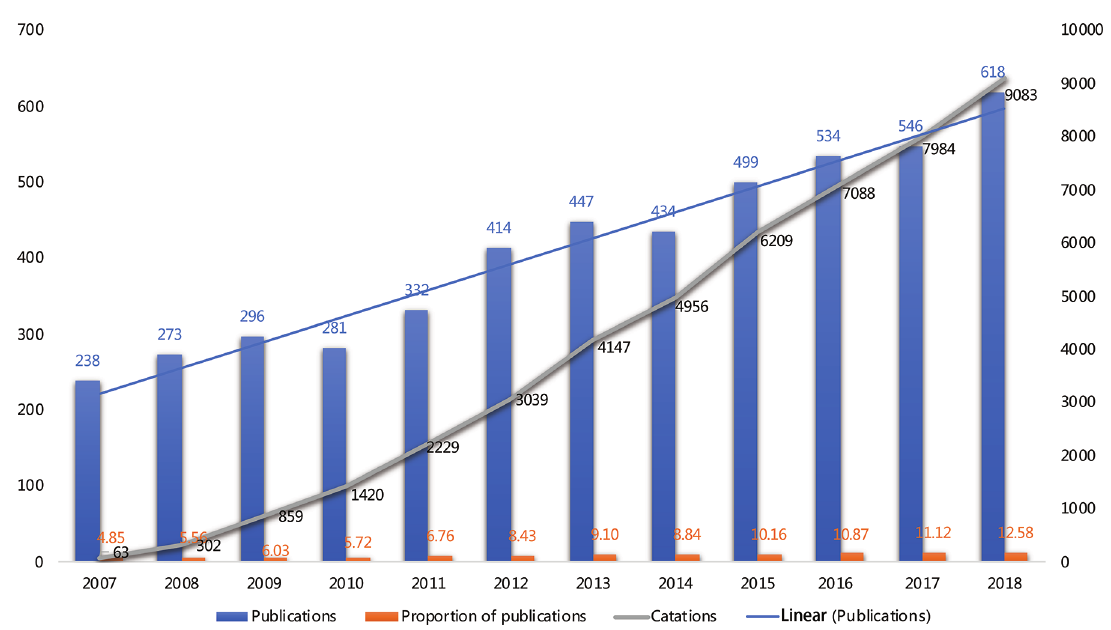
Figure 1. The tendency of publication records and citations related to Nurse Practitioners (2007-2018).